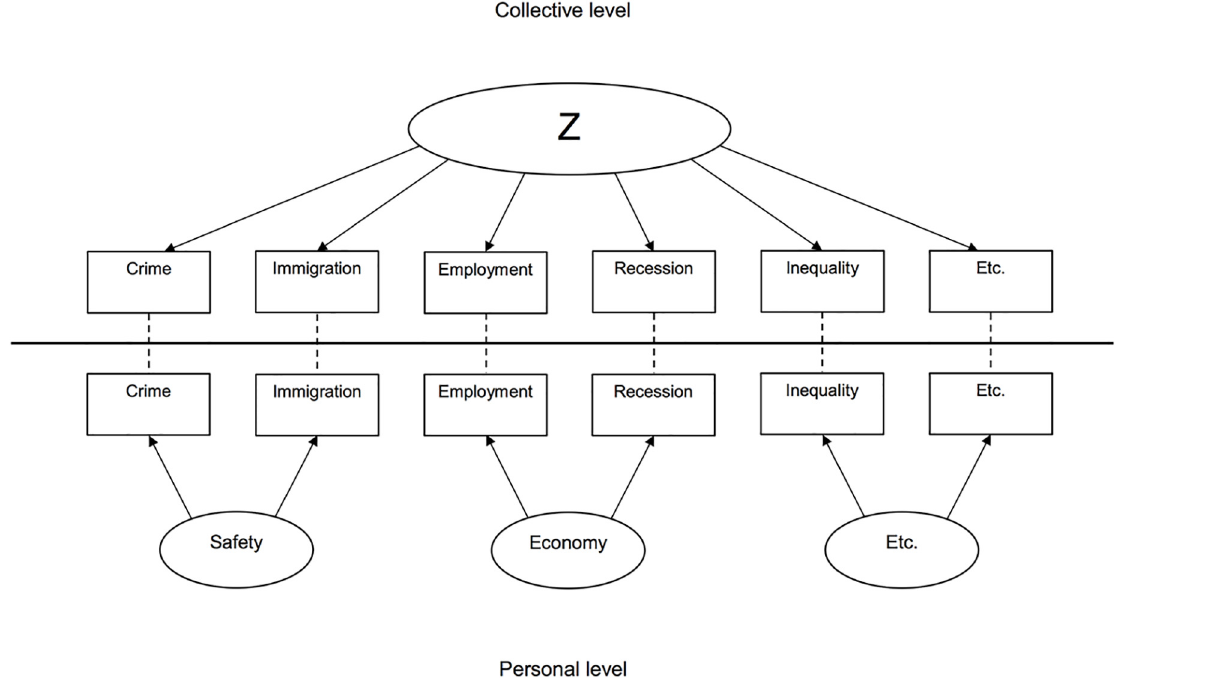
Fig 1. Conceptual model of